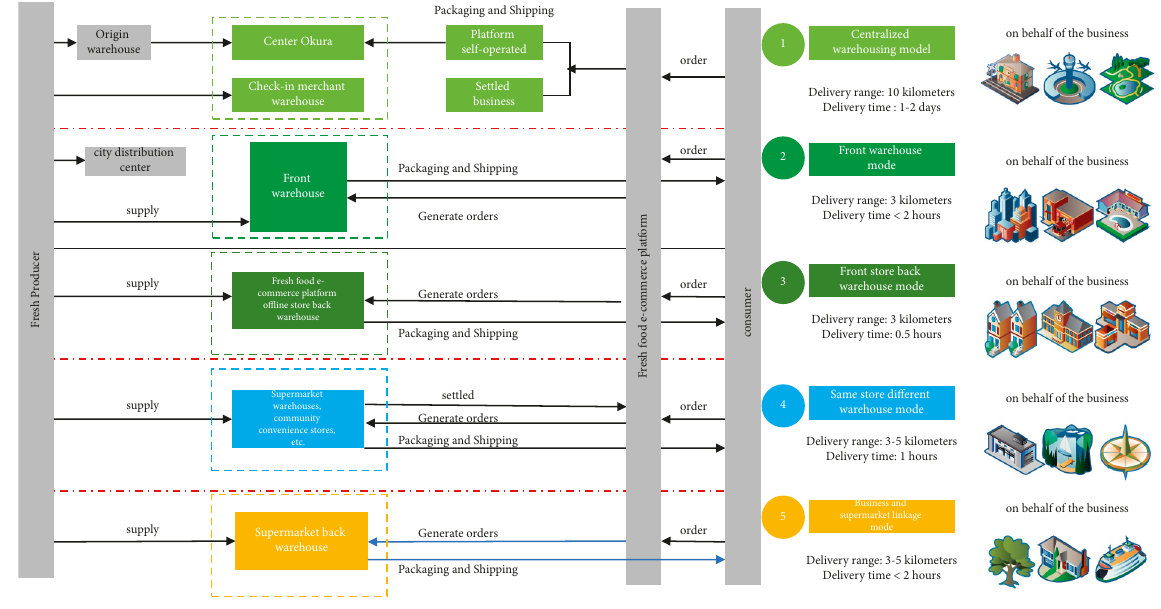
Figure 3: Fresh and new retail